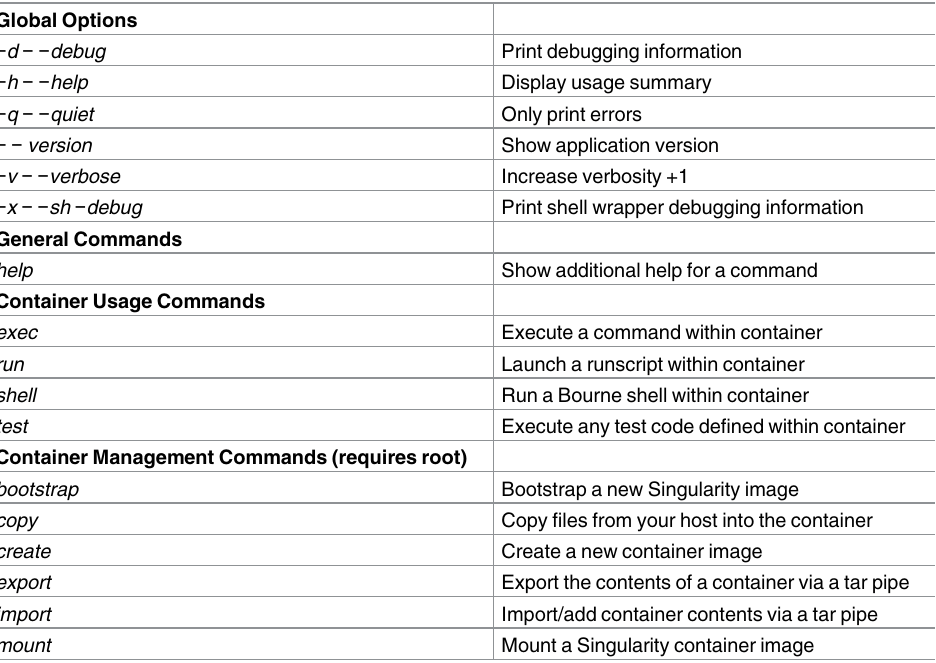
Table 3. Singularity